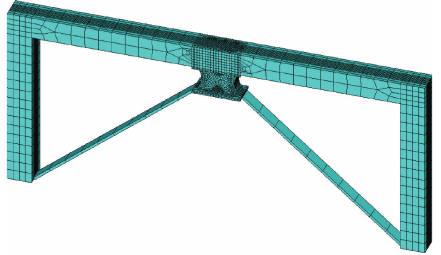
Figure 22: Damper model in the